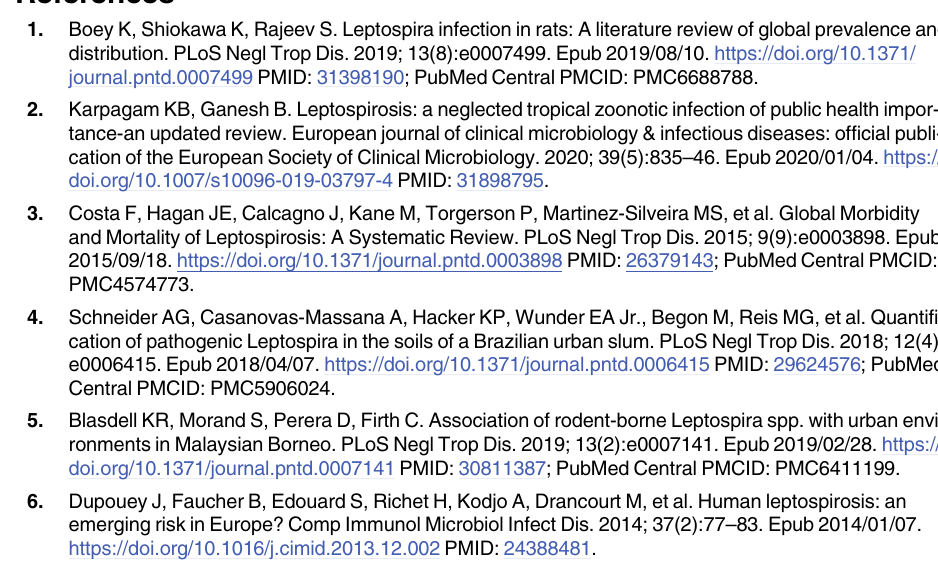
gene in THP-1 and HUVEC, the results indicated target genes were significant knocked down by siRNA treatment. S2 Fig. Distribution in ITGB1 and CAV-1 in the phagocytotic vesicles of THP-1 and HUVEC during infection with L. interrogans strain Lai determined by Western Blot assay. ITGB1, ITGB2, ITGB3 and CAV-1 in the phagocytotic vesicles of THP-1 and HUVEC were detected during infection with L. interrogans strain Lai, phagocytotic vesicles from the lepto- spire-infected THP-1 contained ITGB1 alone, while those from the infected HUVEC pre- sented ITGB1 and